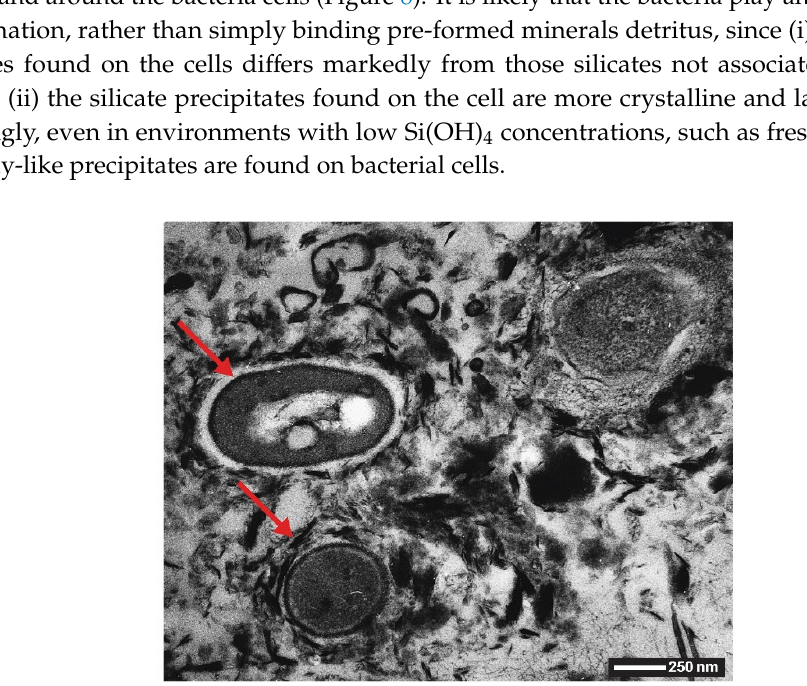
Figure 8. Electron microscopy image of mineral precipitates closely associated with bacterial cells from a microbial mat community in a saline alkaline lake. The thin, dark deposits on and around the cells (arrows) contain a Fe,Mg-silicate, resembling the mineral sepiolite. Scale bar: 250 nm. Reproduced from [84] with permission from Elsevier.